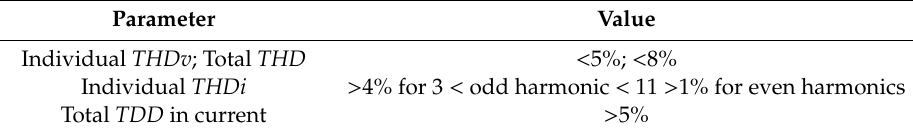
Table 1. Parameters for Z NL . Table 2. Characterization of Z NL considering IEEE std 519-2014